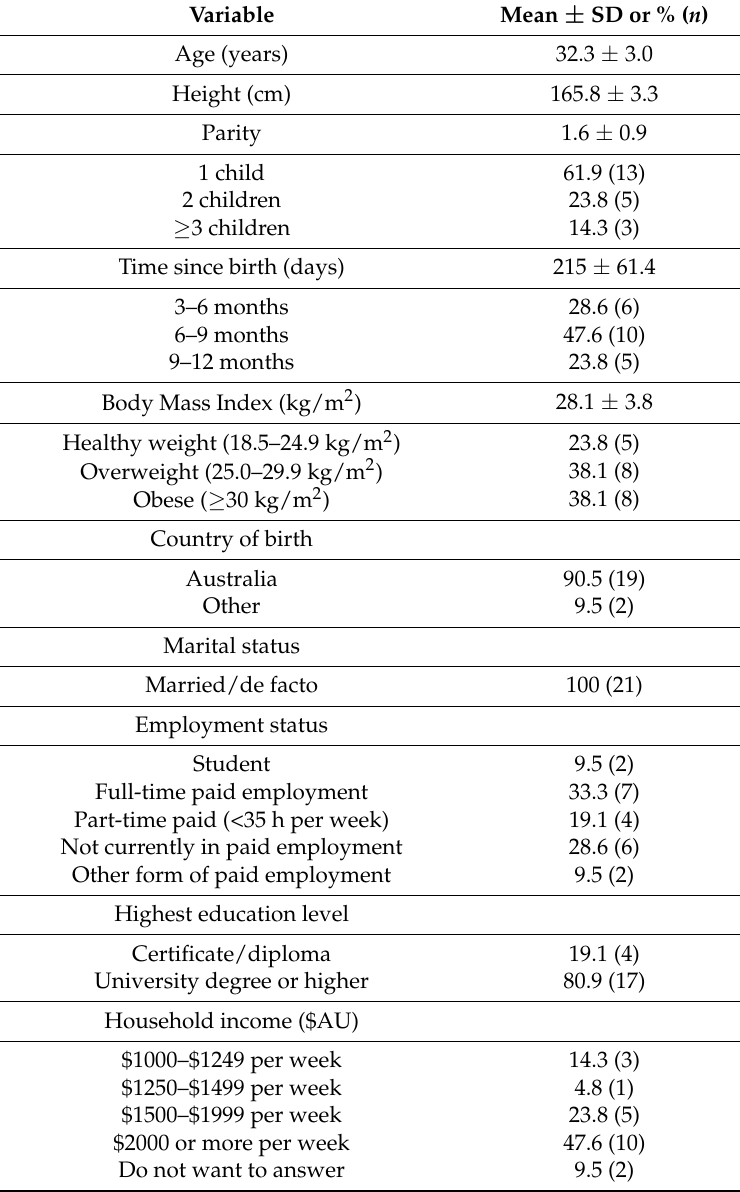
Table 1. Baseline characteristics of participants completing a post-intervention interview following Video-coaching to assist lifestyle (VITAL) change for mums